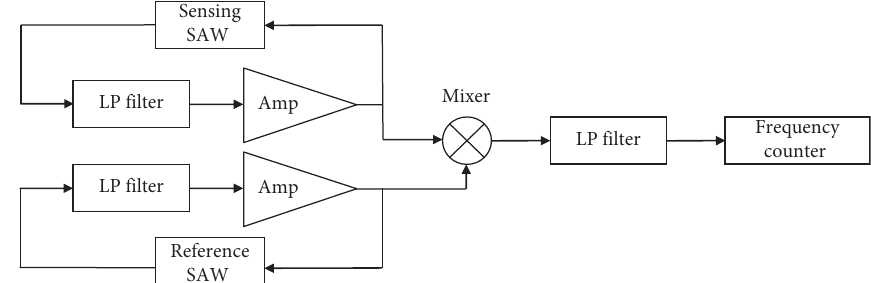
Figure 6: The differential frequency measurement